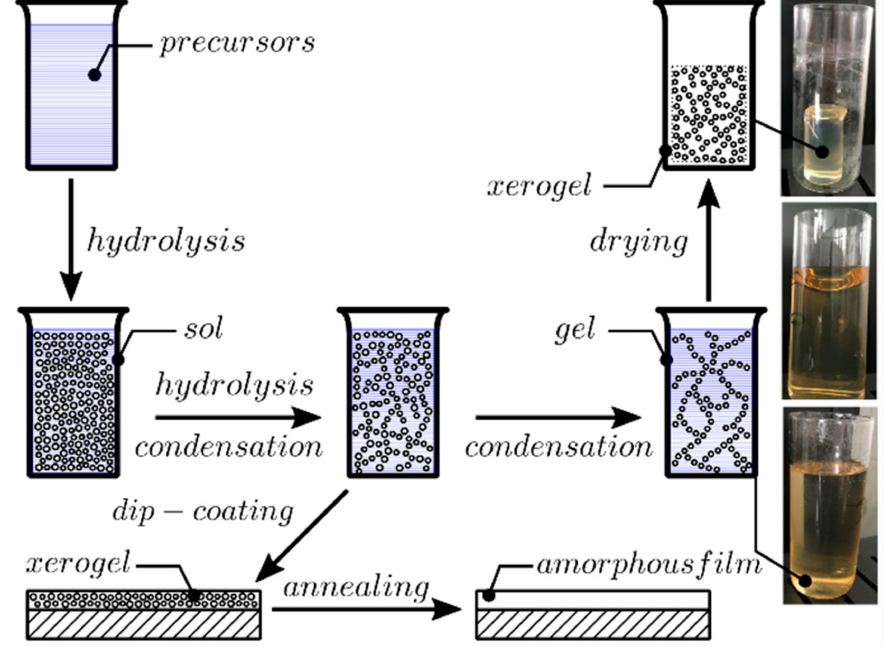
Figure 1. Schematic view of the fabrication process of SiO 2 -TiO 2 waveguide films on BK7 glass substrates utilizing the sol–gel method and dip-coating